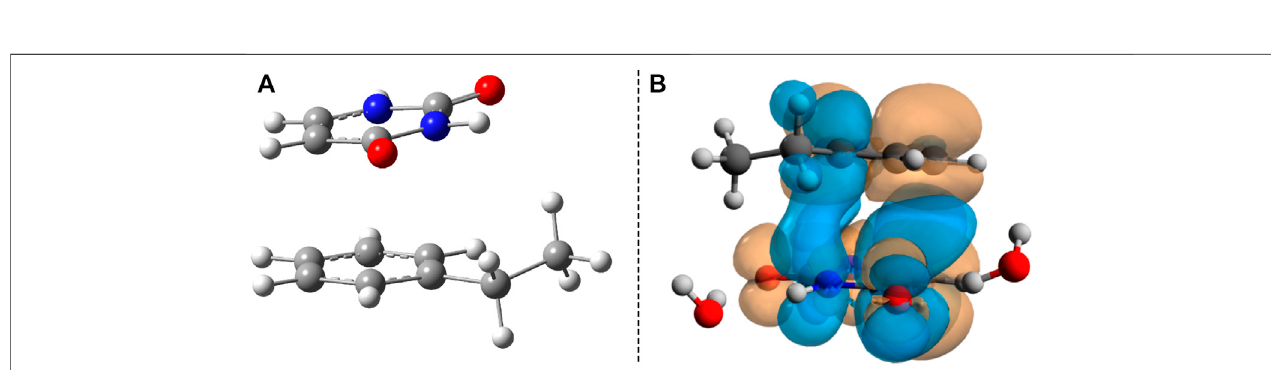
Frontiers in Bioengineering and Biotechnology |